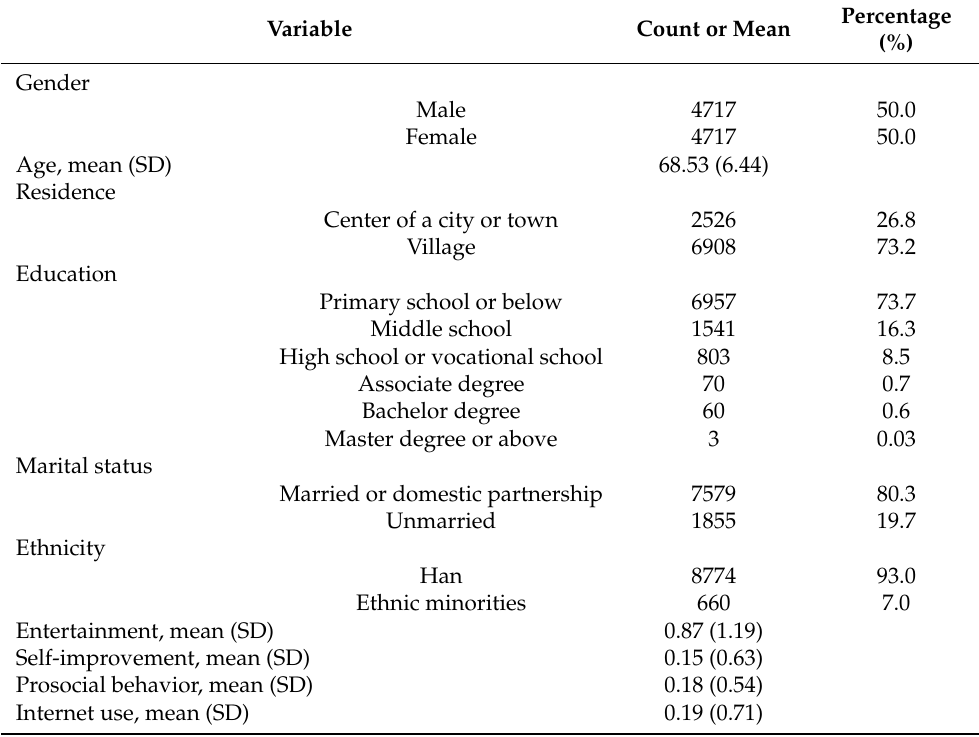
Table 2. Descriptions of the study participants in Sample 2 (N = 9434).